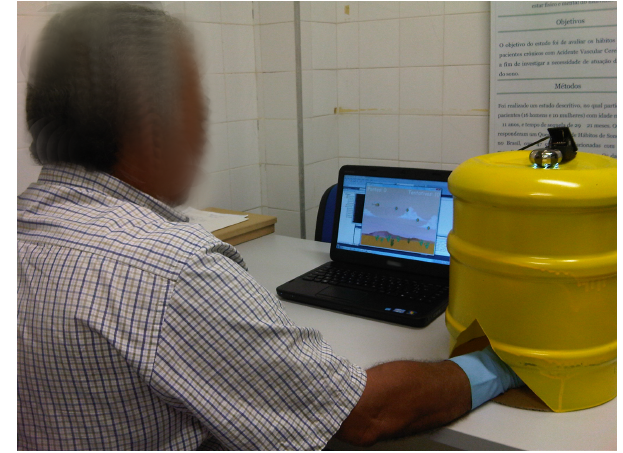
Fig. 10: Experimental set up used with a post-stroke